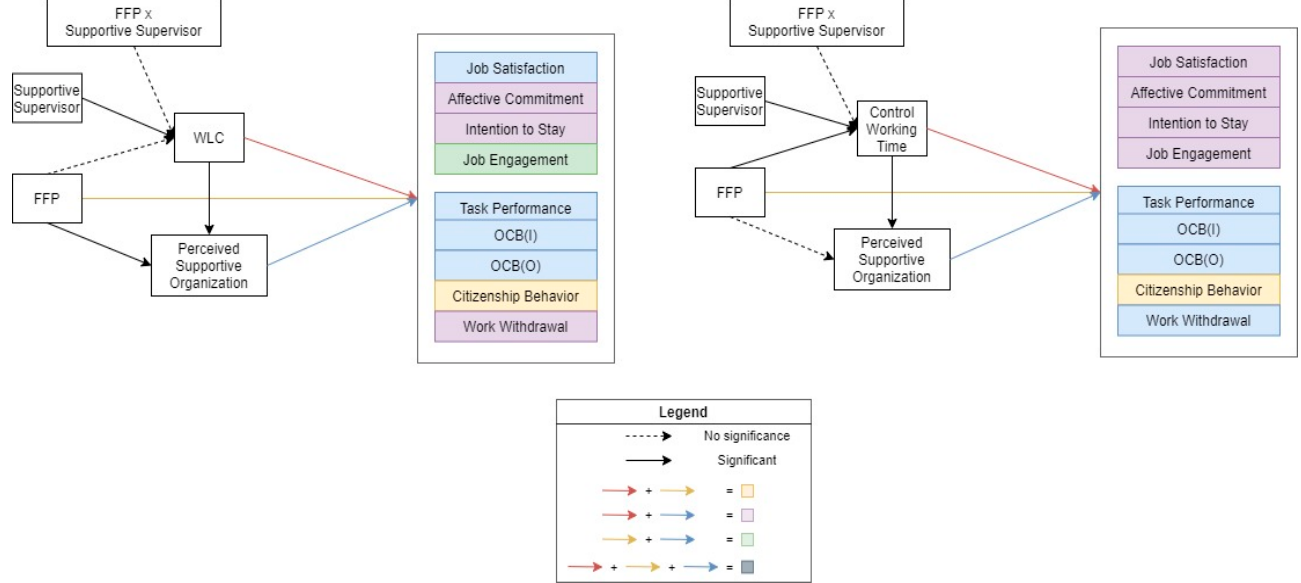
Figure 3. Association of family-friendly policies with work attitude and behavioral outcomes through the moderated serial mediator model.